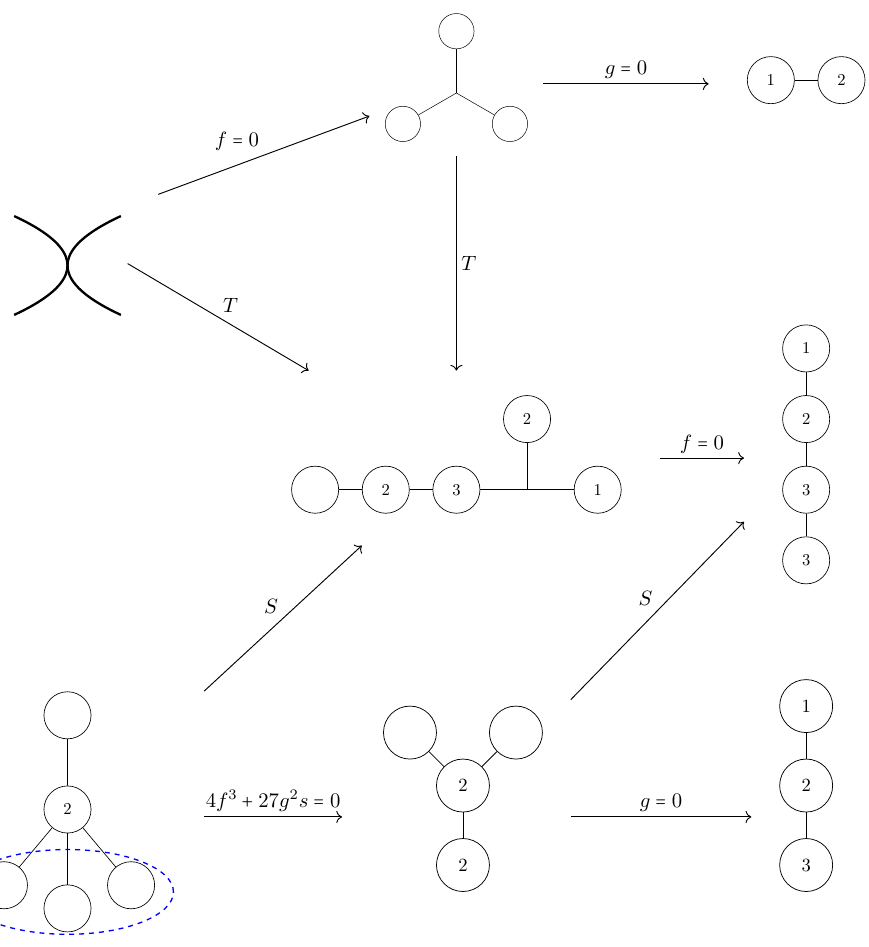
Figure 15 . III + I (cid:3) S 3